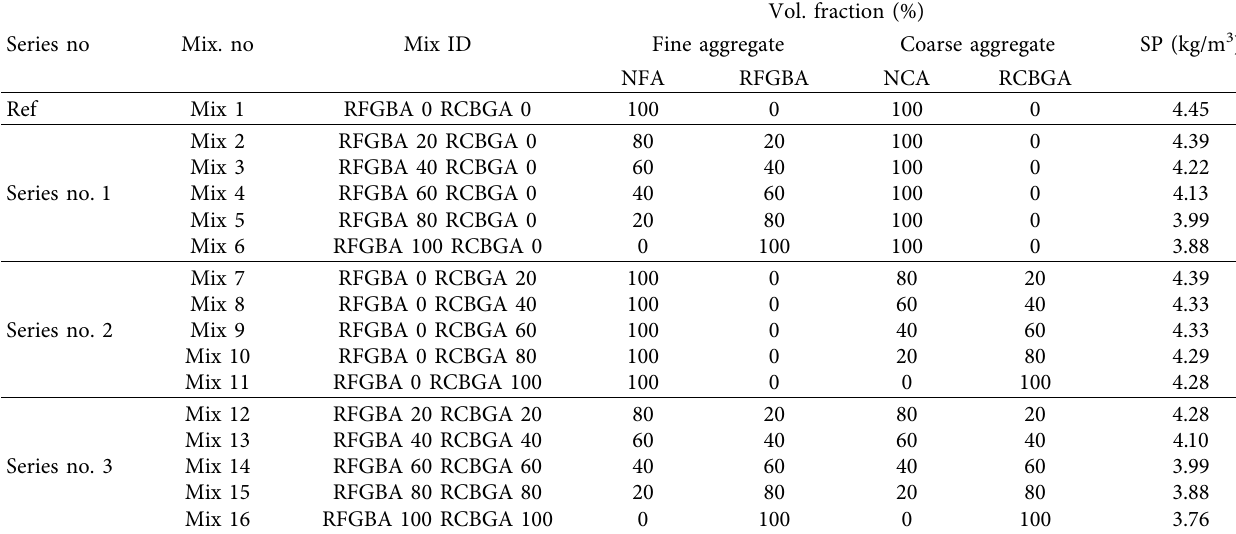
Table 3: Concrete mixture